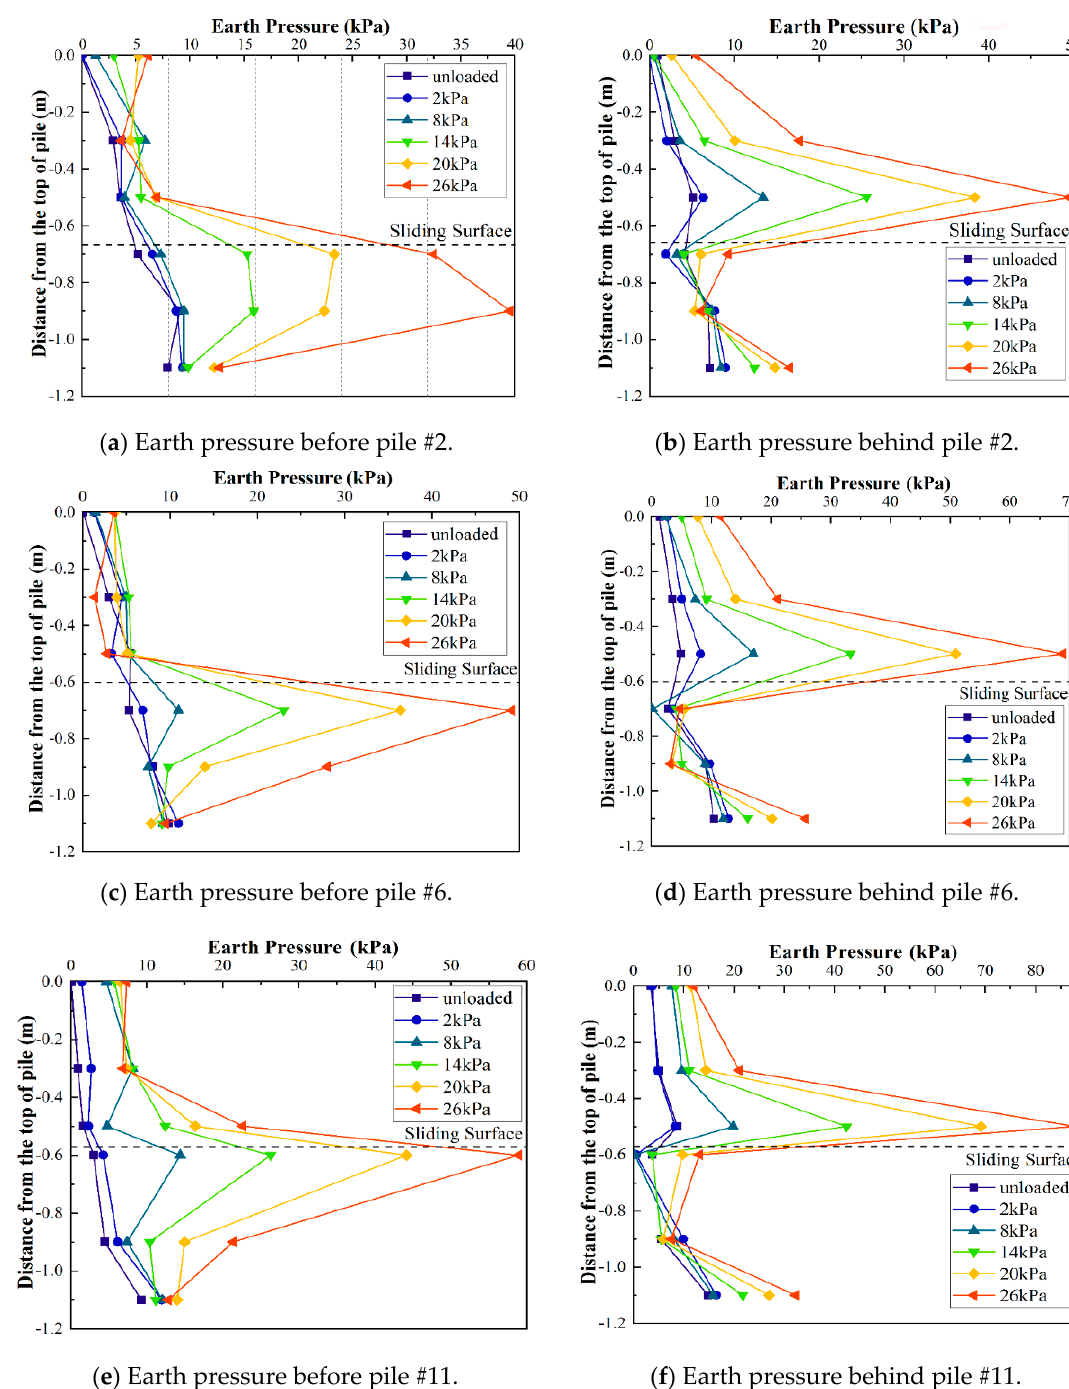
Figure 12. Earth pressure distribution in front of and behind each row of piles in the static model tests.